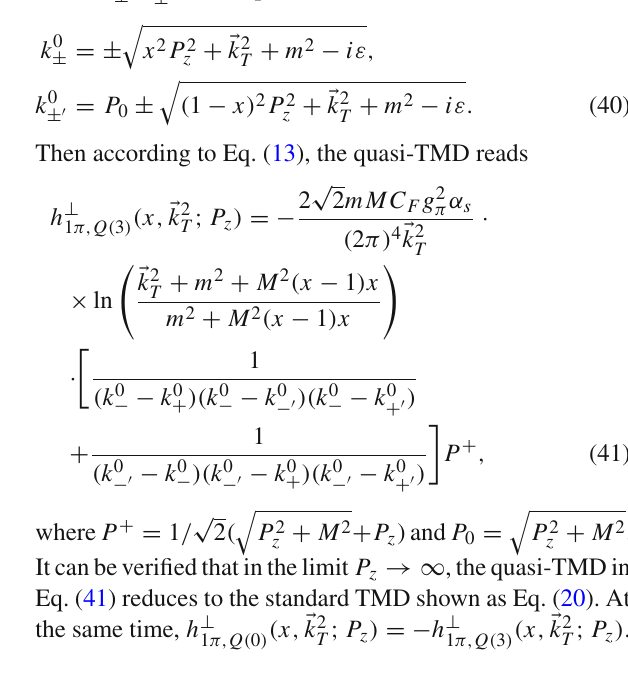
| for different ξ and |(cid:2) (cid:3) | values. The upper and lower panels display T T ( x ,ξ, (cid:2) k 2 , (cid:2) (cid:3) 2 ) at | (cid:2) (cid:3) | = 0 and 0 . 5, T T T 1